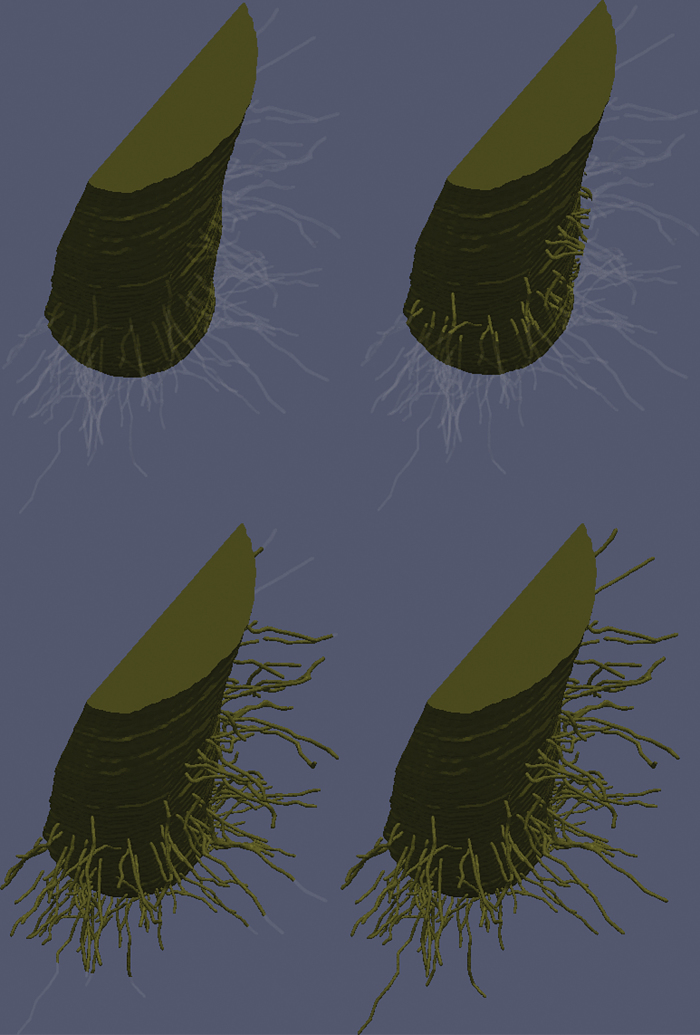
Root growth scenario for four different times. Top left shows the initial condition (0h), top right shows the hair growth after 16h, bottom left shows hair growth after 32h, and bottom right shows hair growth after 48h. (This figure is available in colour at JXB online.)